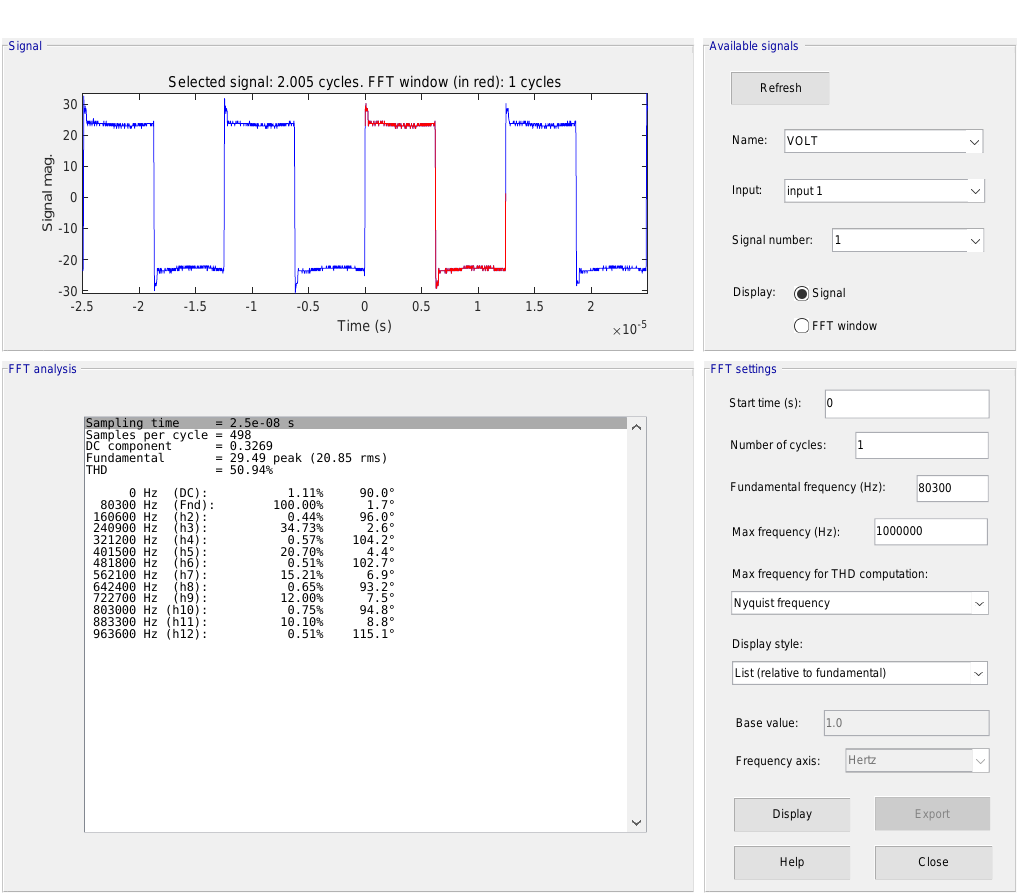
Figure 10. FFT analysis result for output voltage measured in the experimental